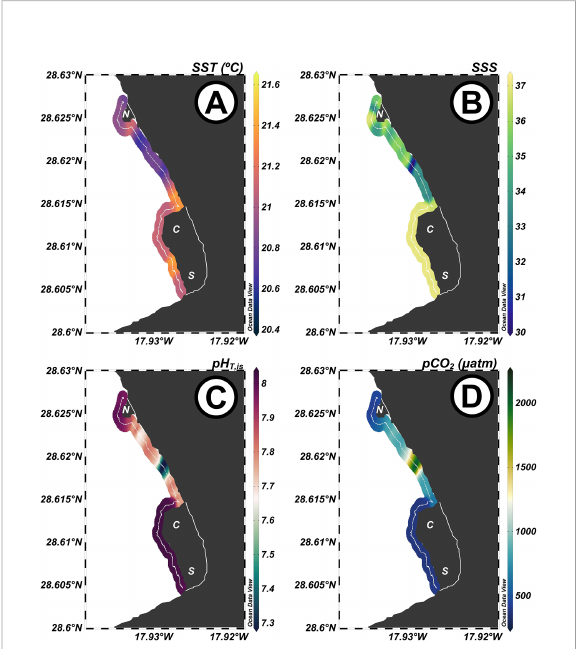
FIGURE 2 Surface distribution of (A) temperature (SST, °C), (B) salinity (SSS), (C) pH in total scale at in-situ conditions (pH T,is ), and (D) partial pressure of CO 2 (pCO 2 , µatm) along the new shoreline with the two new formed deltas (approximated shape) in the coast of Tazacorte, La Palma during 11th January 2022, 1 month after the emission of lava fi nalized. North (N), center (C), and south (S) correspond with the locations of the pre-lava arrival